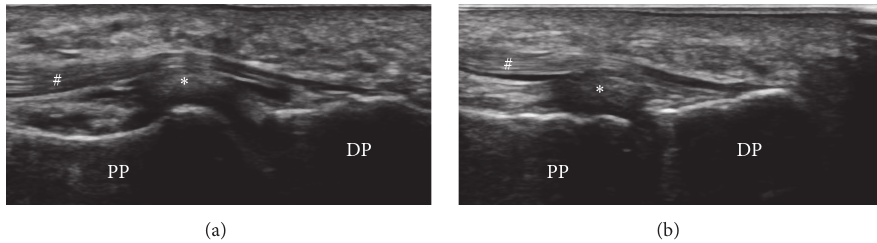
Figure 3: Ultrasonography image of the interphalangeal joint (IPJ) showed fluid retention around the plantar capsule nodule and flexor hallucis longus tendon on the affected side, but not on the healthy side, of the great toe. (a) Affected side. (b) Healthy side. DP: distal phalanx and PP: proximal phalanx. ∗ Plantar capsule nodule. # Flexor hallucis